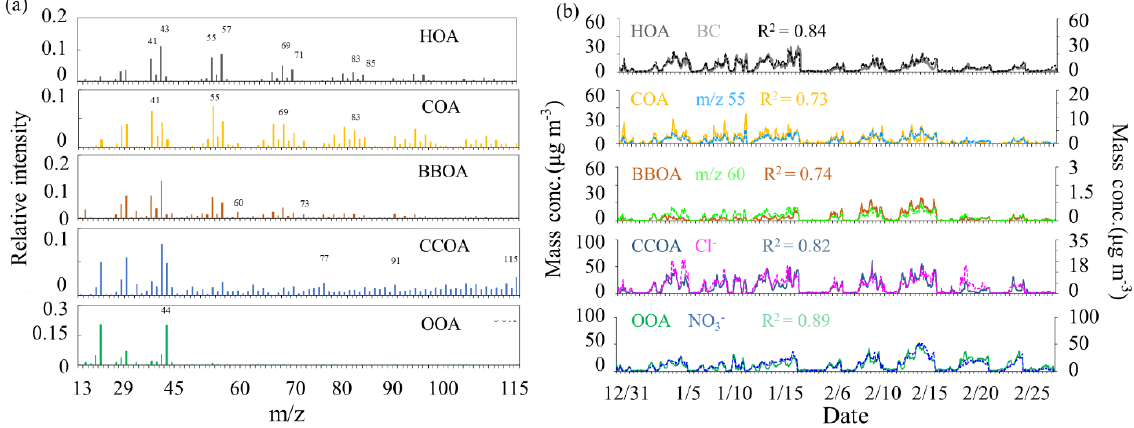
Figure 3. The mass spectra (a) and time series (b) of OA factors (HOA, COA, BBOA, CCOA and